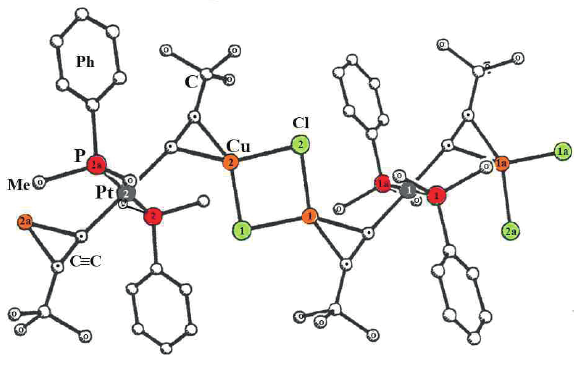
Ph) Pt(C ≡ CBu t ) 2 2